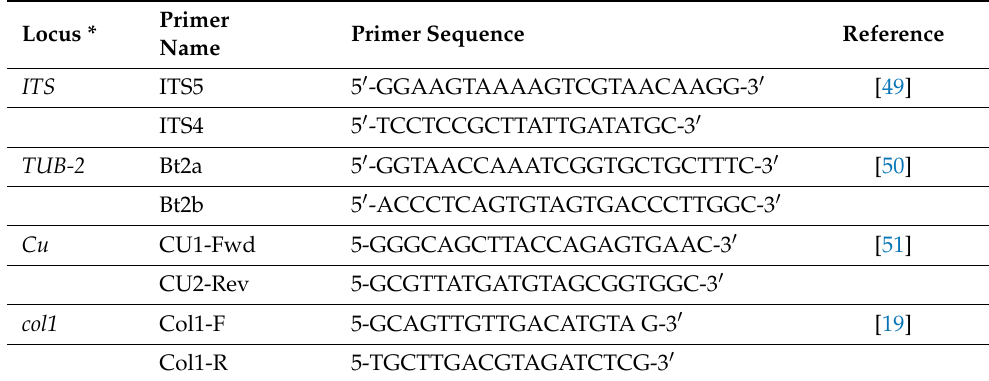
Table 1. Details of the primer pairs used for PCR in this